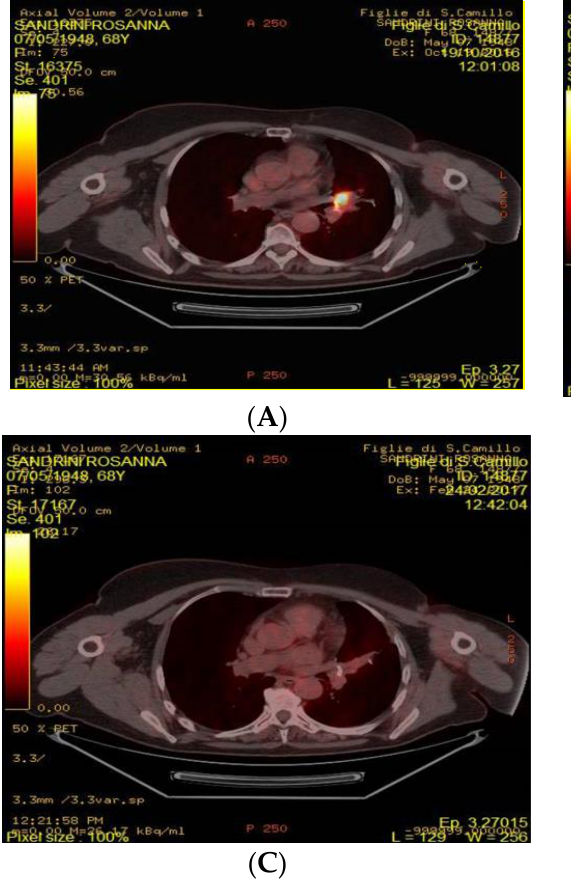
Figure 4. FDG-PET performed at baseline, after one month and after three months. ( A ) FDG-PET / CT performed at baseline: appearance of intense hyperaccumulus due to parenchymal thickening in the left peri-hilar area, with a segmental lingularcharactern (SUVmax 14.6) ( B ) FDG.PET performed after 1 months: Clear reduction of intense hyper-accumulation, however minimal residual collection remains (SUVmax 3.5) ( C ) FDG-PET / CT performed after 3 months unchanged the uptake previously